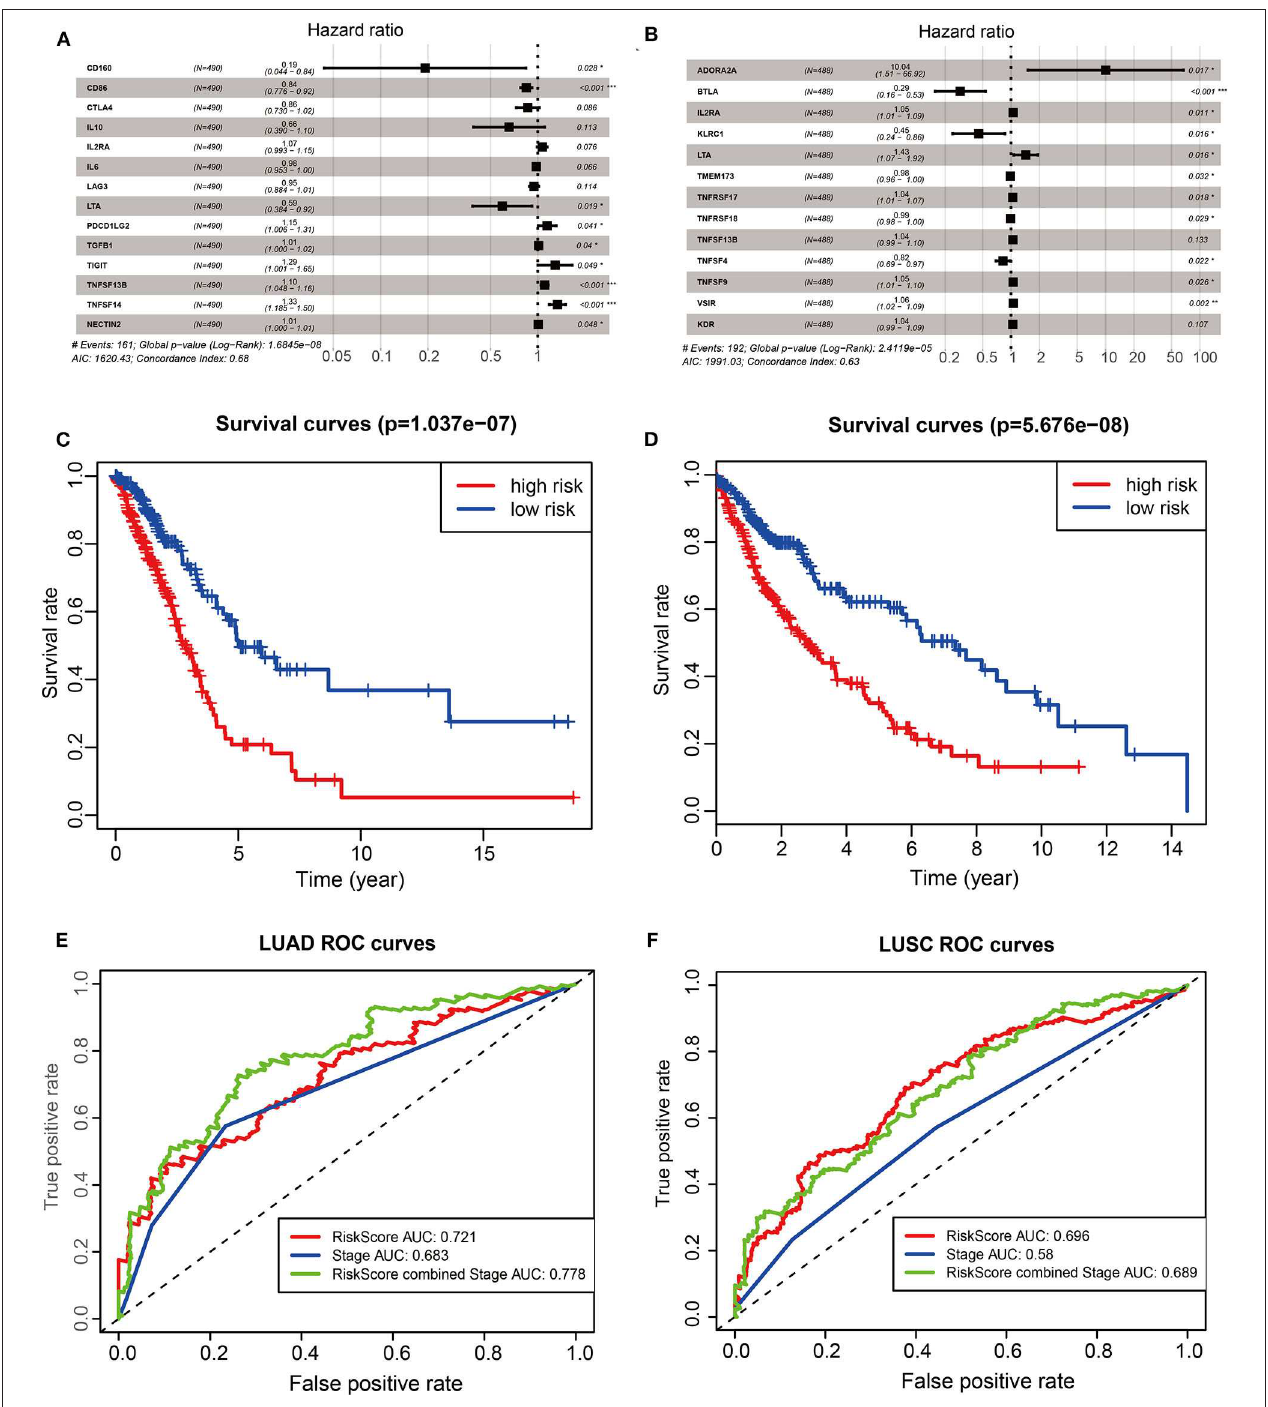
FIGURE 6 | The development of prognostic gene signatures based on 35 ACK1-associated immunomodulators and ACK1. The hazard ratios of genes integrated into the prognostic signatures are shown in the forest plots for LUAD (A) and LUSC (B) . Kaplan–Meier curves for LUAD (C) and LUSC (D) regarding the risk scores. Time-dependent receiver operating characteristic curves at 5-years for LUAD (E) and LUSC (F)